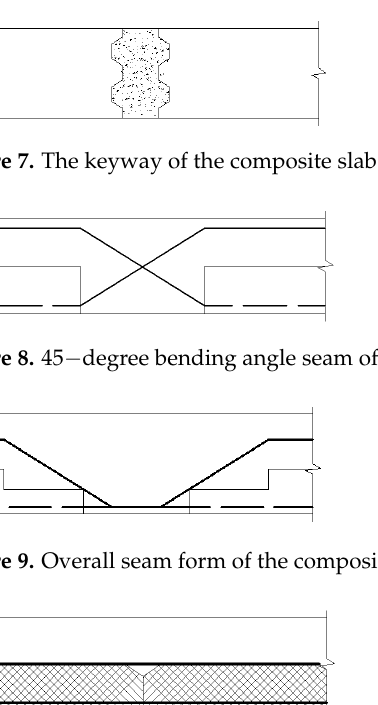
Figure 10. The splicing structure in the form of the additional steel bars.